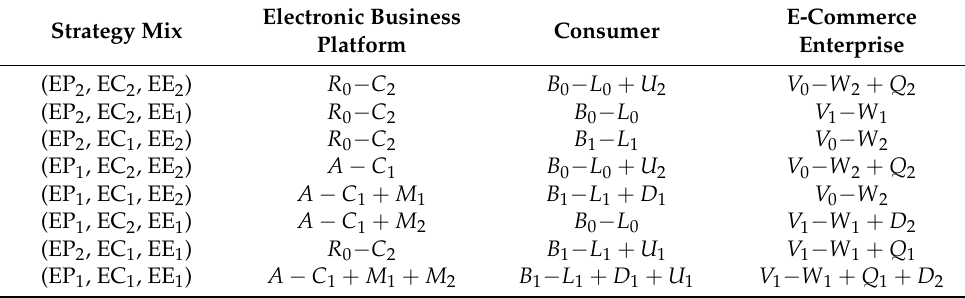
Table 1. Game revenue matrix without government